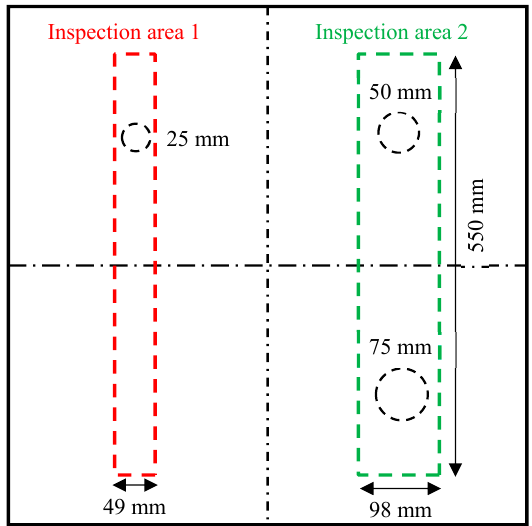
Figure 5. Schematic of non-destructive testing (NDT) inspection areas on the cross-ply [0/90] 2s CFRP composite plate.